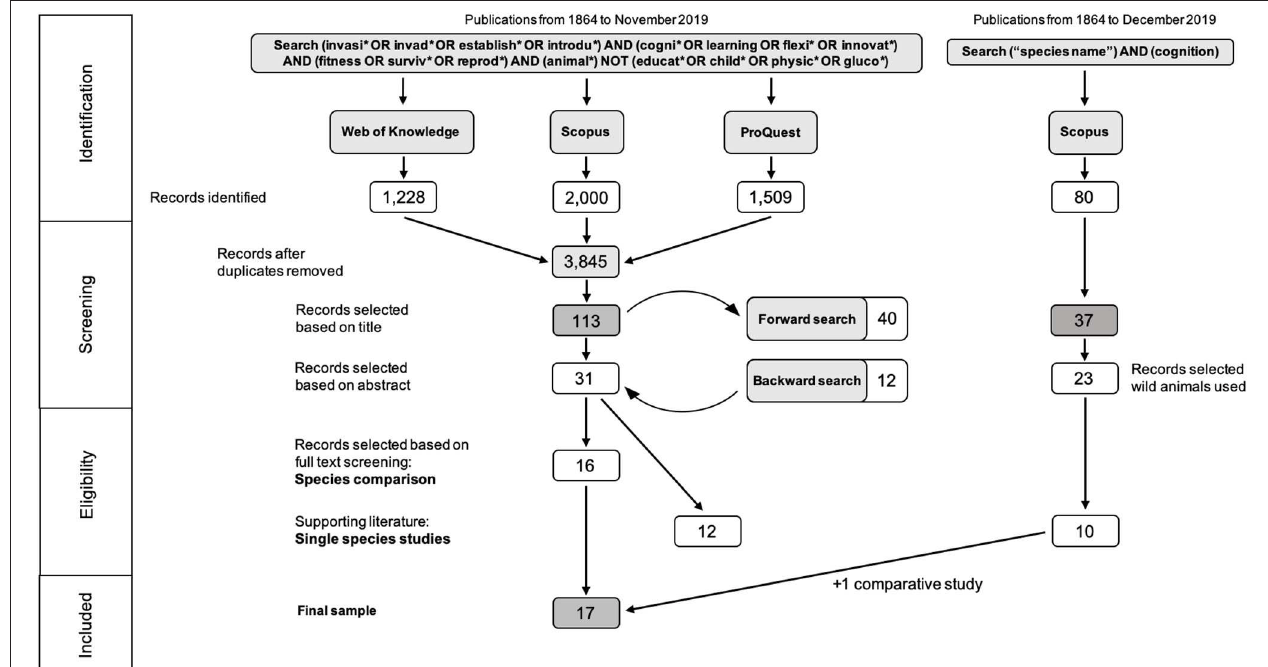
FIGURE 2 | Graphical representation of the systematic literature compilation (PRISMA diagram) including details on search terms, databases searched, number of entries found, and number of entries selected at each step.